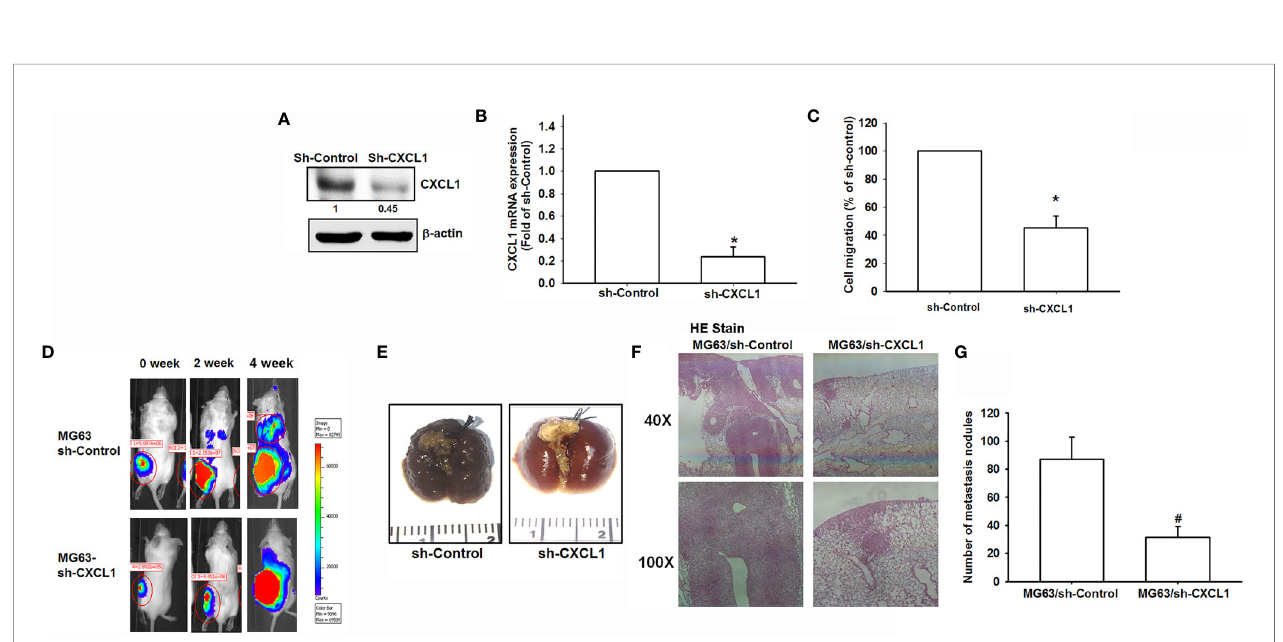
FIGURE 6 | The CXCL1/CXCR2 axis is required for osteosarcoma lung metastasis. (A, B) Protein and mRNA levels of CXCL1 and (C) cell migration ability of MG63 transfected with sh-CXCLl by immunoblotting, real-time qPCR, and Transwell assays in MG63 cells. (D) The mice were injected with MG63/control shRNA, or MG63/ CXCL1 shRNA cells. Lung metastasis was monitored by bioluminescence imaging at the indicated time intervals. (E – G) The appearance of hematoxylin and eosin stain and numbers of metastasis nodules of lung specimens from sacri fi ce mice after 4 weeks of cell injection was shown. Results are expressed as the mean ± S.D. of triplicate samples. */ # p < 0.05 as compared to the shRNA-control